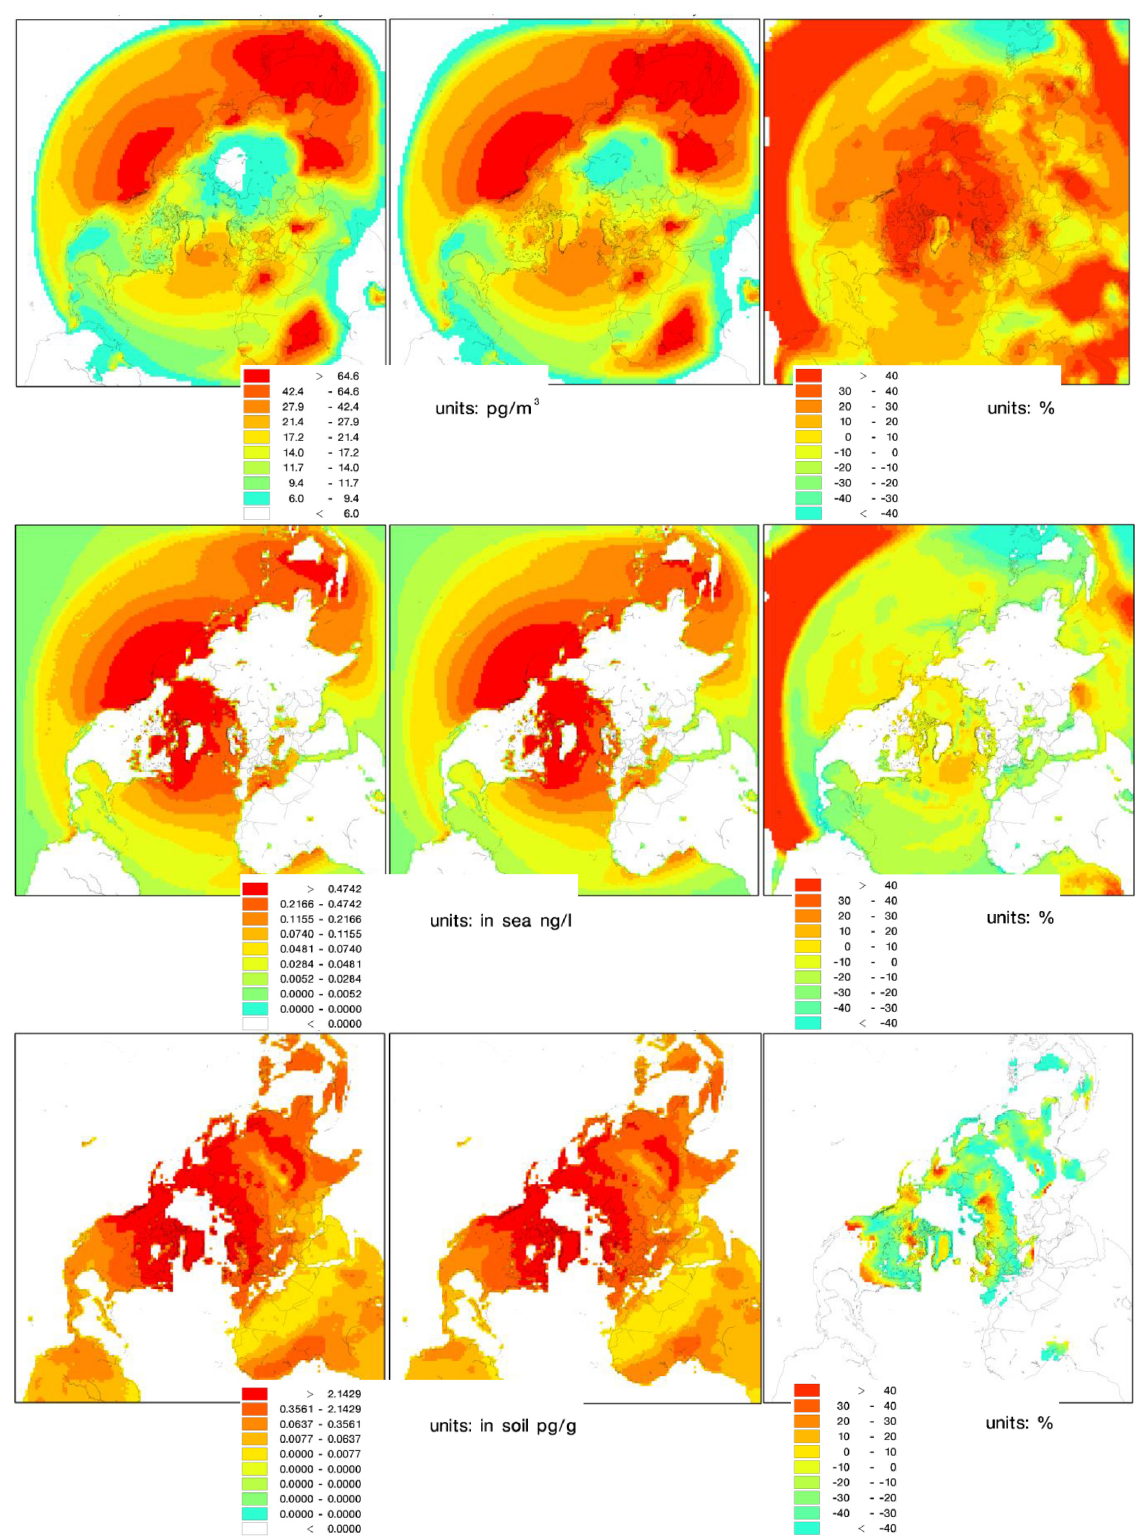
Figure 2. Annually averaged α -HCH concentrations in the lowermost atmospheric layer (top row) in ocean water (middle row) and soil (bottom row) for 1999 (left column) and 2099 (middle column) and the difference in percent between 1999 and 2099 (right column) for the ES